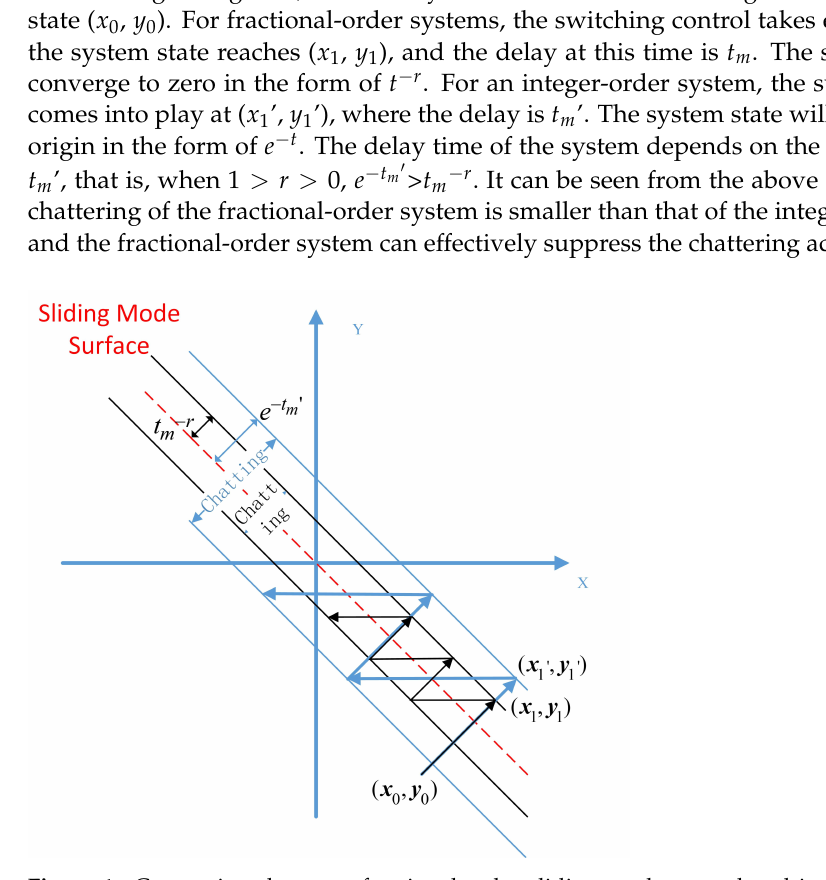
Figure 1. Comparison between fractional-order sliding mode control and integer-order sliding mode